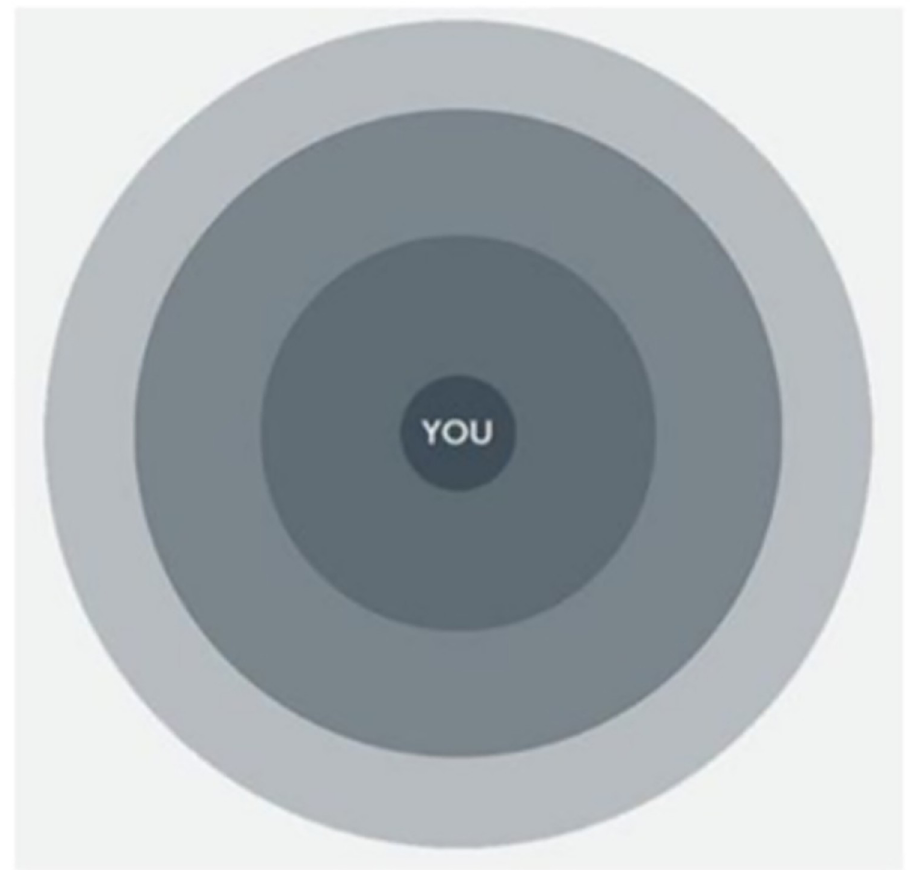
Fig 1. Concentric circles used during interview. The circles nearest the most inner circle represents support systems most important to the